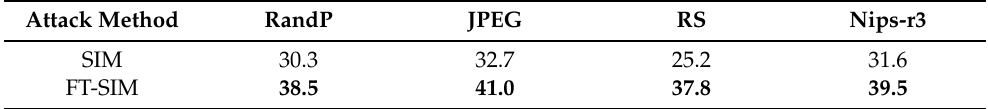
Table 6. The black-box ASRs of SIM and FT-SIM on ImageNet against four defense methods. The adversarial examples are generated with Inc_v3. The values in the table are the average ASRs (%) on the Inc_v4, IncRes_v2, and Xcep. The higher ASRs are shown in